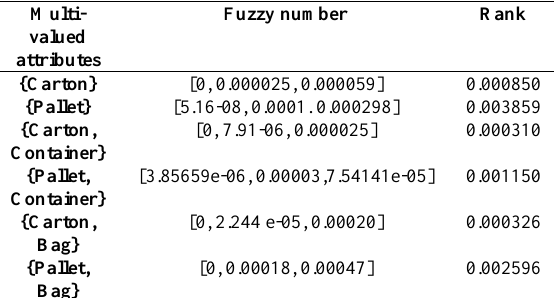
Table 2. Ranks of fuzzy numbers for some multi-valued attributes for parceling. Multi-